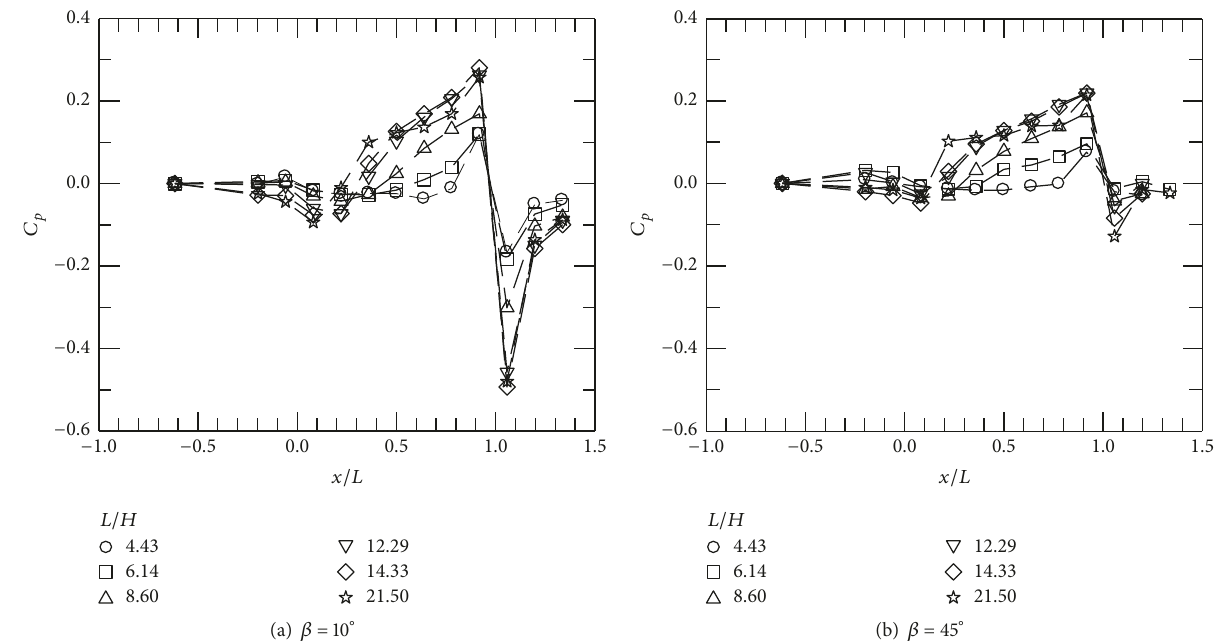
Figure 2: The chord-wise distributions of the mean surface pressure at M = 0.83: (a) 𝛽 = 10 ∘ and (b) 𝛽 = 45 ∘ .